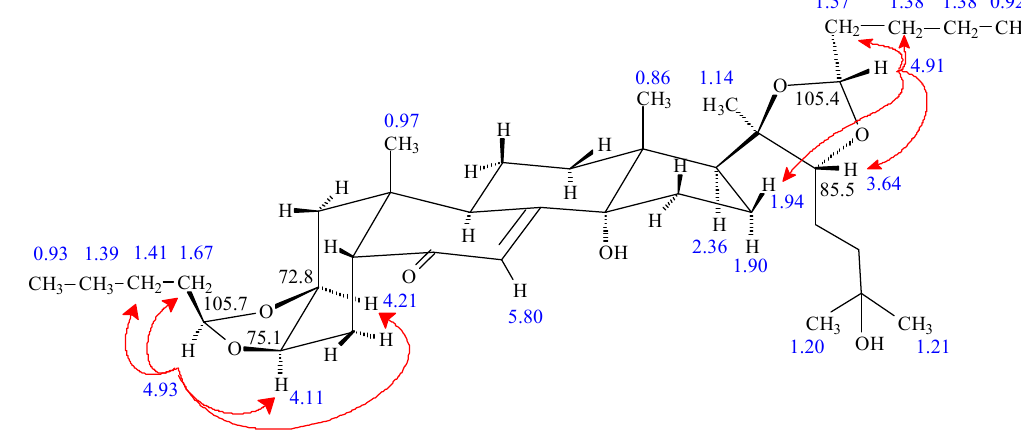
Figure 2. Stereostructure of 22 . Red arrows indicate the detected ROESY steric proximities, the blue numbers give the characteristic 1 H, and the black numbers the 13 C chemical